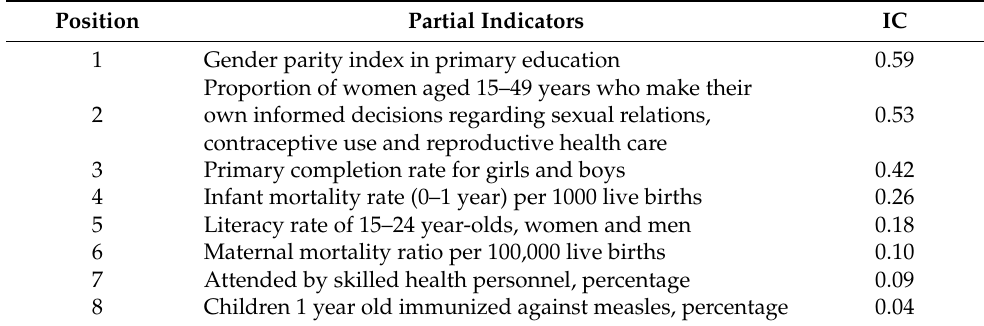
Table 3. Amount of information on the variables on SDG3: Good Health and Wellbeing in LDCs of Asia,